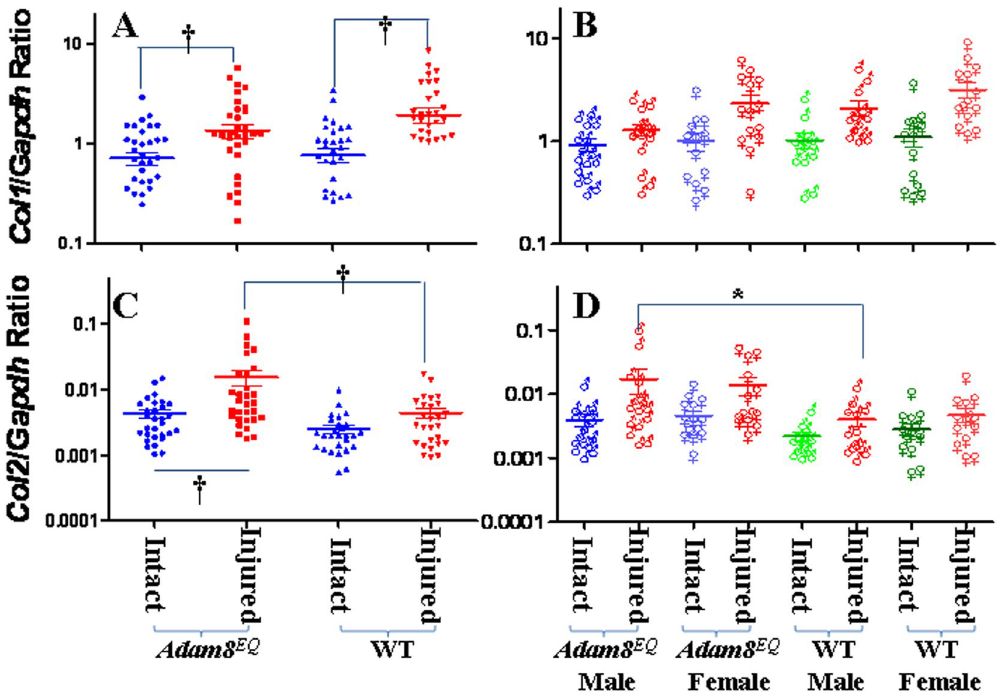
Figure 3. Collagen gene expression in the injured mouse tail intervertebral disc. ( A , B ) Col1a1 gene expression; ( C , D ) Col2a1 gene expression. WT wild type. Each point shows data from one intervertebral disc. † p ≤ 0.01; *p ≤ 0.05.